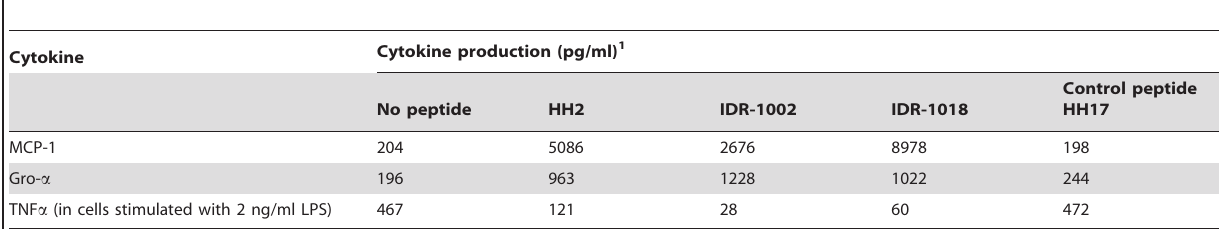
Table 1. Immunomodulatory activities of peptides IDR-HH2, IDR-1002 and IDR 1018 in human peripheral blood mononuclear cells (PBMC).